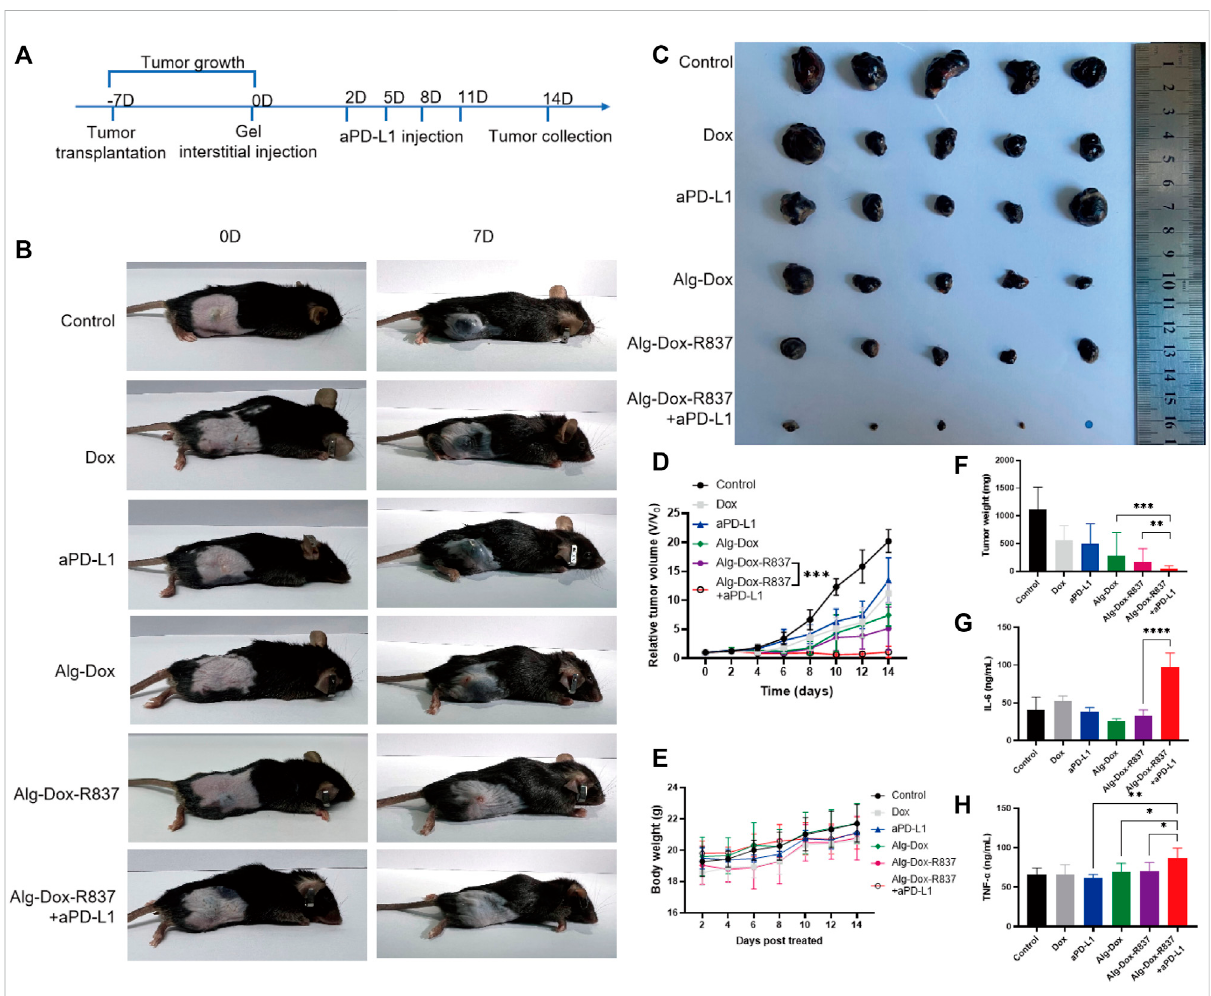
FIGURE 4 Invivo antitumoref fi cacy (A) Dosingscheduleofinterstitum-basedchemo-immunotherapy invivo ; (B) Tumorimageafter14 daysoftreatment in mice; (C) Image of isolated tumor after 14 days; (D) Treatment time curve of relative tumor volume during 14 days; (E) Curve of body weight with differenttreatments; (F) Weightofisolatedtumorafter14 daysoftreatment; (G) SecretedIL-6inmiceserumafter14 daysoftreatment; (H) Secreted TNF- α in mice serum after 14 days of